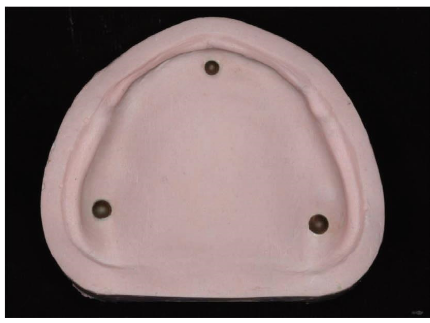
Figure 1: An edentulous maxillary reference model with 3 referent